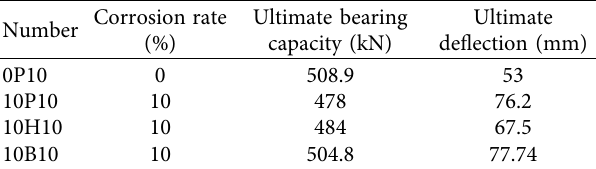
Figure 11: Cracking distribution of specimens with 10% corrosion rate. (a) 10P10, (b) 10H10, and (c) 10B10. Table 3: Ultimate bearing capacity and deflection of specimens.